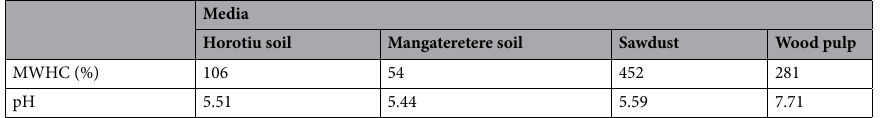
Table 1. Maximum water holding capacity values and pH the four media measured prior to commencement of the degradation